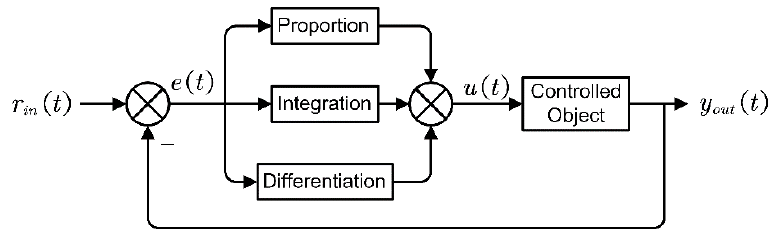
Figure 5. Schematic diagram of conventional PID control system.